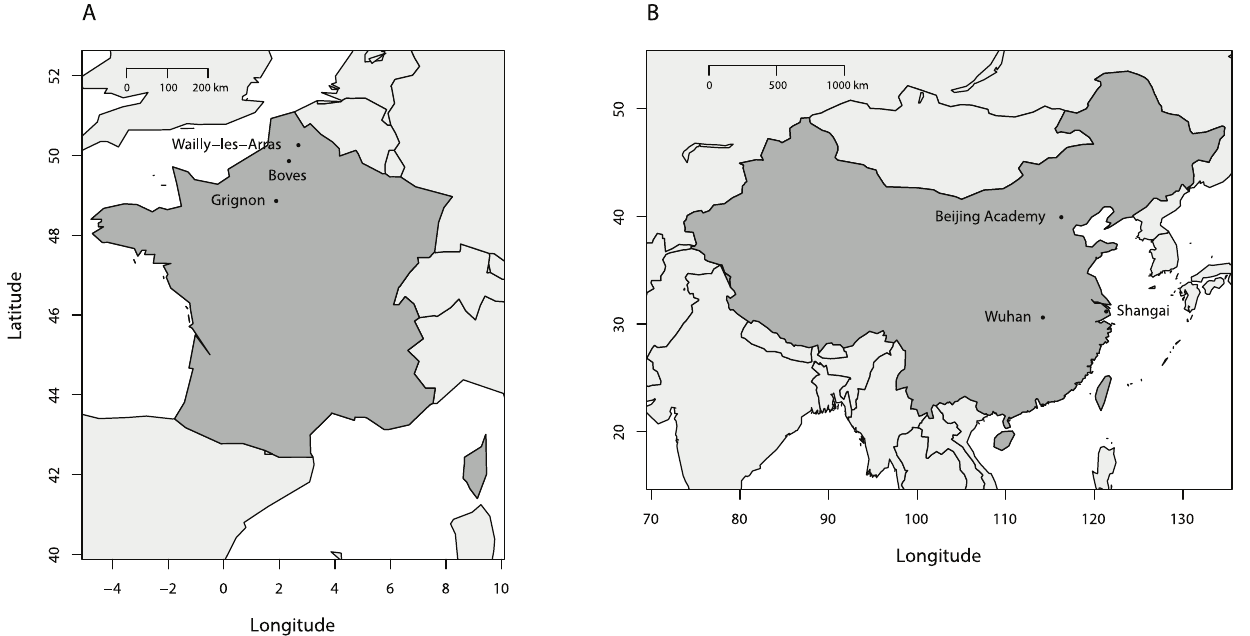
Figure 1. Geographic location of samples in France (A) and China (B).